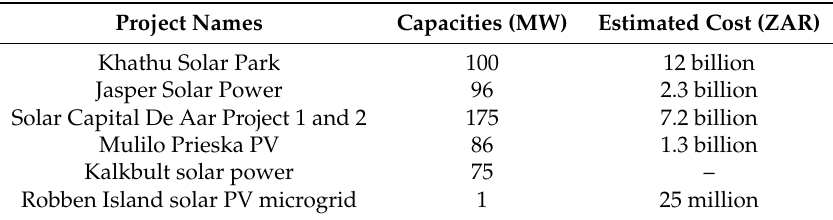
Table 4. Some of SA renewable energy projects with capacities and estimated costs in South African Rands